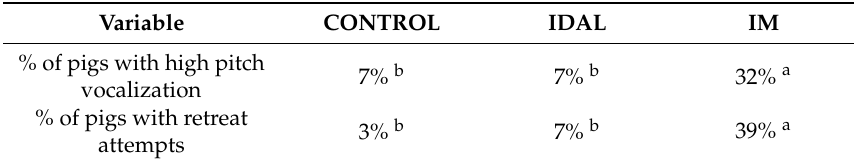
Table 2. Percentage of pigs showing retreat attempts and high pitch vocalizations at the time of injection in the CONTROL, Intradermal (IDAL), and Intramuscular (IM) groups.